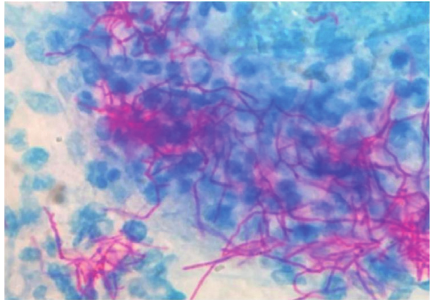
Figure 4: Modified ZN stain showing acid-fast branching Table 1: Clinical and microbiological data of patients.